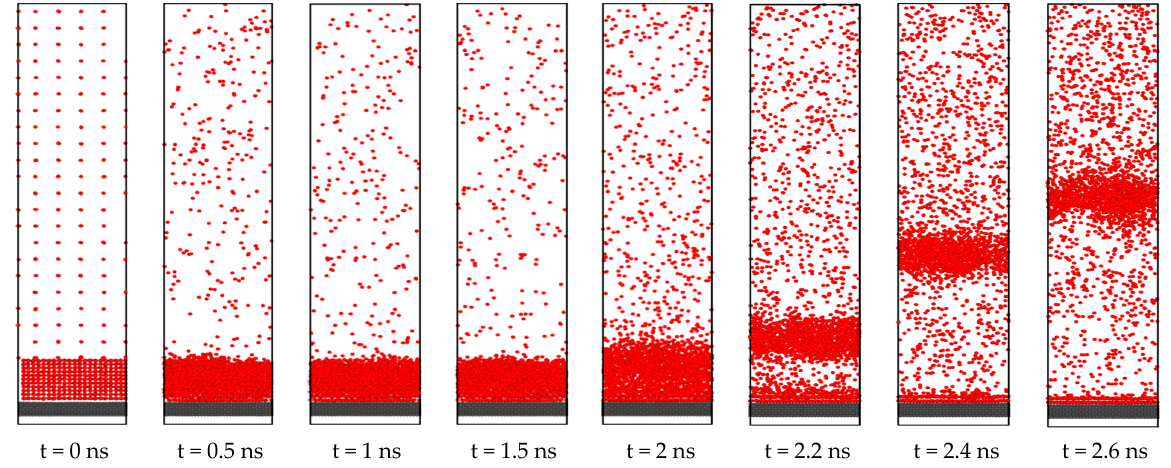
Figure 2. Explosive boiling of liquid argon at 173 K temperature.